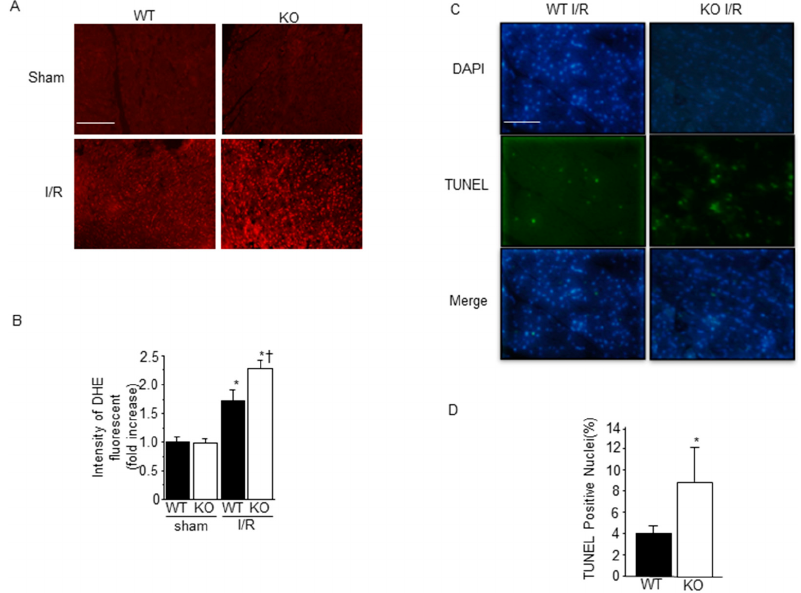
Figure 2. Increased myocardial apoptosis and ROS generation in SMP30 KO mice: ( A ) Representative images of DHE staining of frozen left ventricular tissues 30 min after I/R or sham operation in SMP30 KO and WT mice; ( B ) Quantitative analysis of intensity of DHE fluorescent. Data are reported as mean ± SE ( n = 6). DHE, dihydroethidium. Scale bars: 100 μ m. * p < 0.05 vs. sham-operated mice, and † p < 0.05 vs. WT I/R mice; ( C ) Representative TUNEL-stained sections from WT and SMP30 KO mice subjected to 30 min of ischemia and 24 h of reperfusion or sham operation; ( D ) Percentages of TUNEL-positive nuclei in sections from WT and SMP30 KO mice. Data are reported as mean ˘ SE ( n = 6). TUNEL, TdT-mediated dUTP nick end-labeling. Scale bars: 200 µ m. * p < 0.05 vs. sham-operated